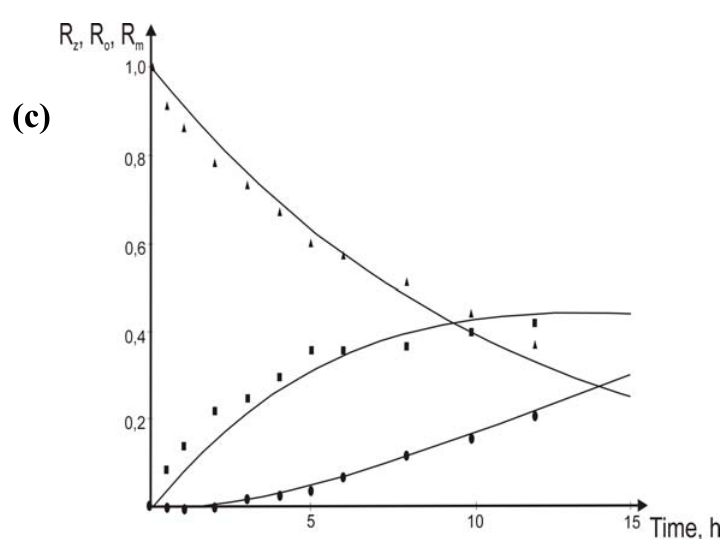
) and exit F ) and exit (J ) fluxes with initial chromium F S